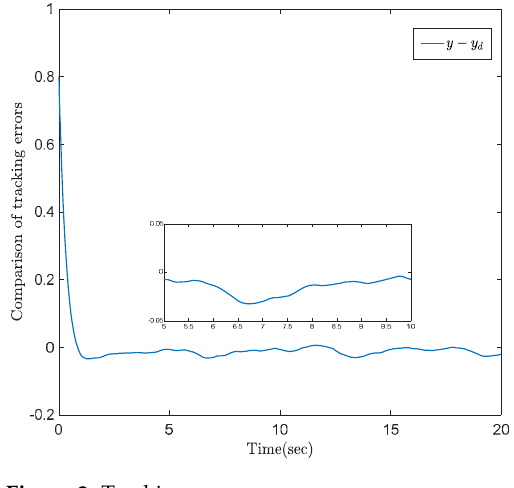
Figure 1. Output y and